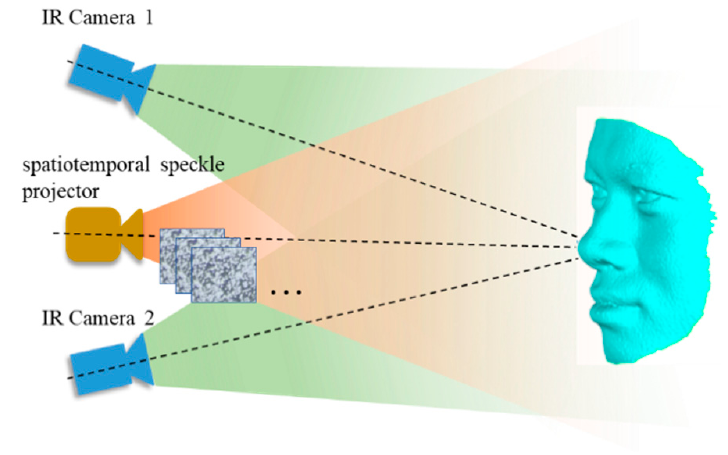
Figure 1. Spatiotemporal stereo scheme for fast three-dimensional face reconstruction.